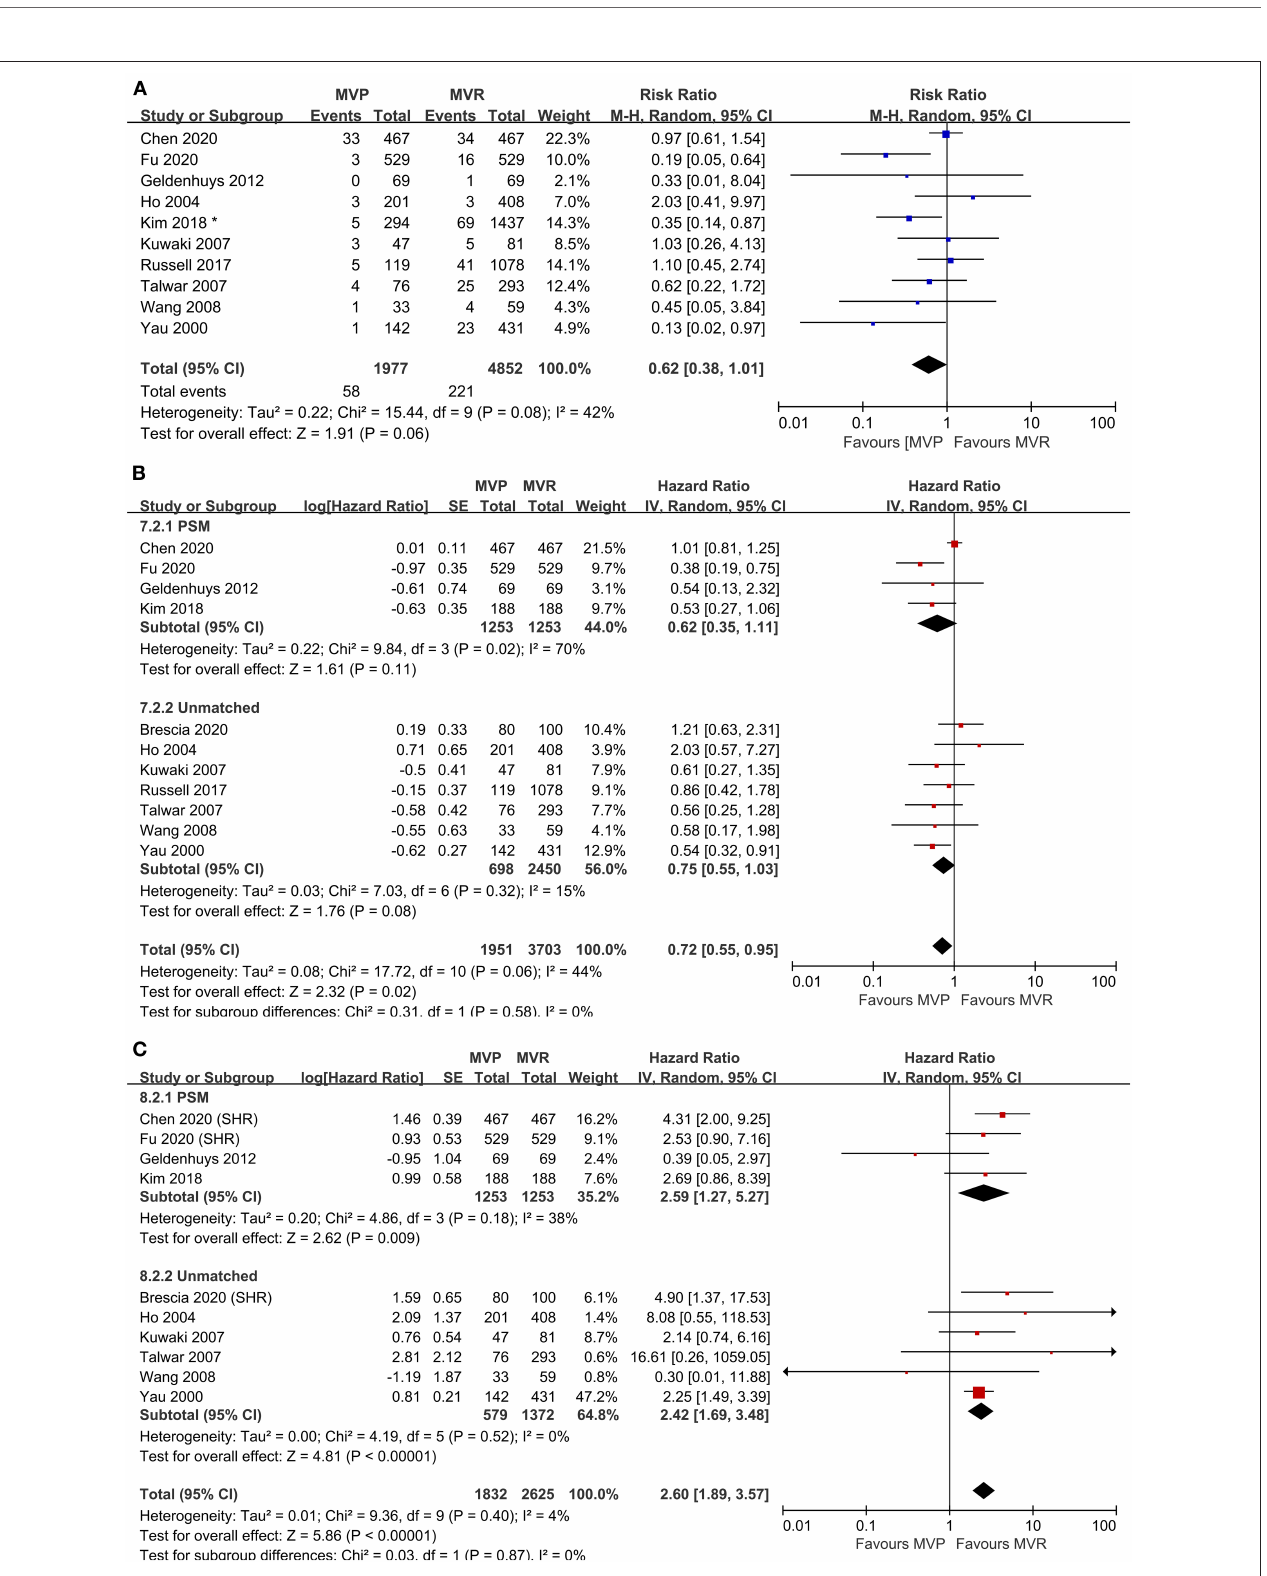
FIGURE 1 | Forest plots showing the results of early and late outcomes. (A) Early mortality, (B) long-term survival, analyzed by study design, and (C) freedom from reoperation, analyzed by study design. MVP, mitral valve repair; MVR, mitral valve replacement; M-H, Mantel-Haenszel; CI, confidence interval; SE, standard error; IV, Inverse-Variance; PSM, propensity score matching; SHR, subdistribution hazard ratio; *before matching.